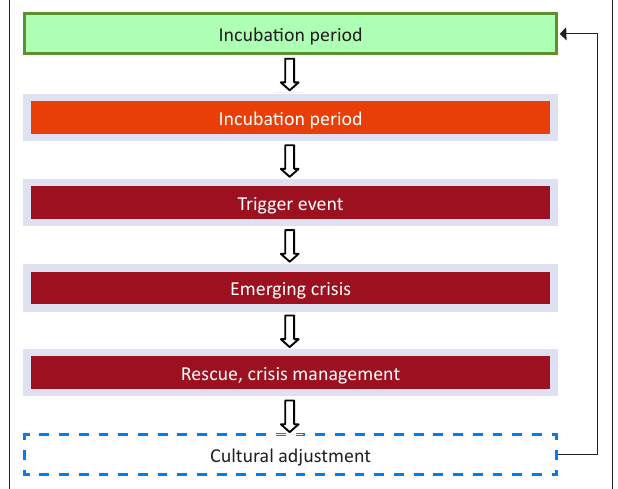
FIGURE 3: Accident investigation